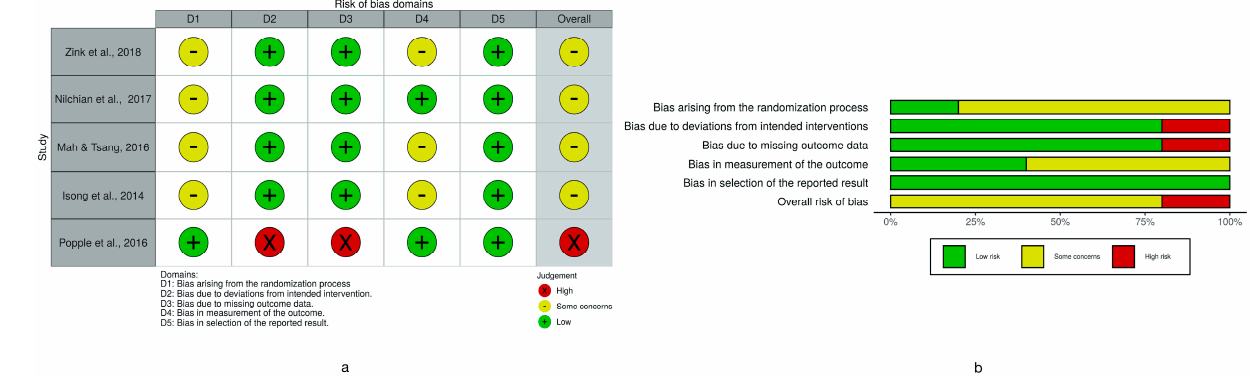
Figure 2. Risk of bias assessment of RCTs using the ROB-2 tool. ( a ) Traffic light plot of RCT bias assessment. ( b ) Weighted summary plot of the overall type of bias encountered in RCTs.